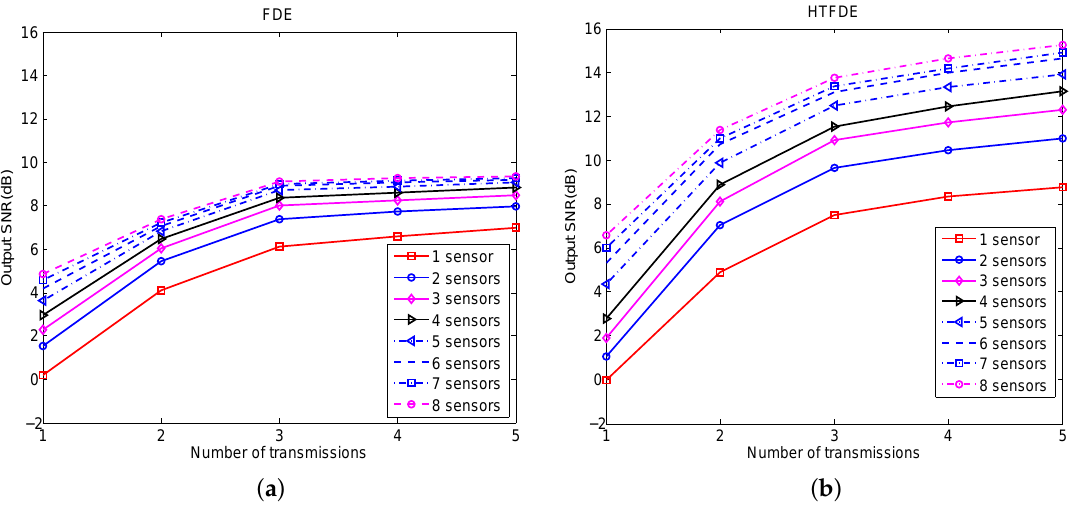
Figure 10. Output SNR as a function of the number of transmissions and the number of elements used. ( a ) FDE results and ( b ) HTFDE